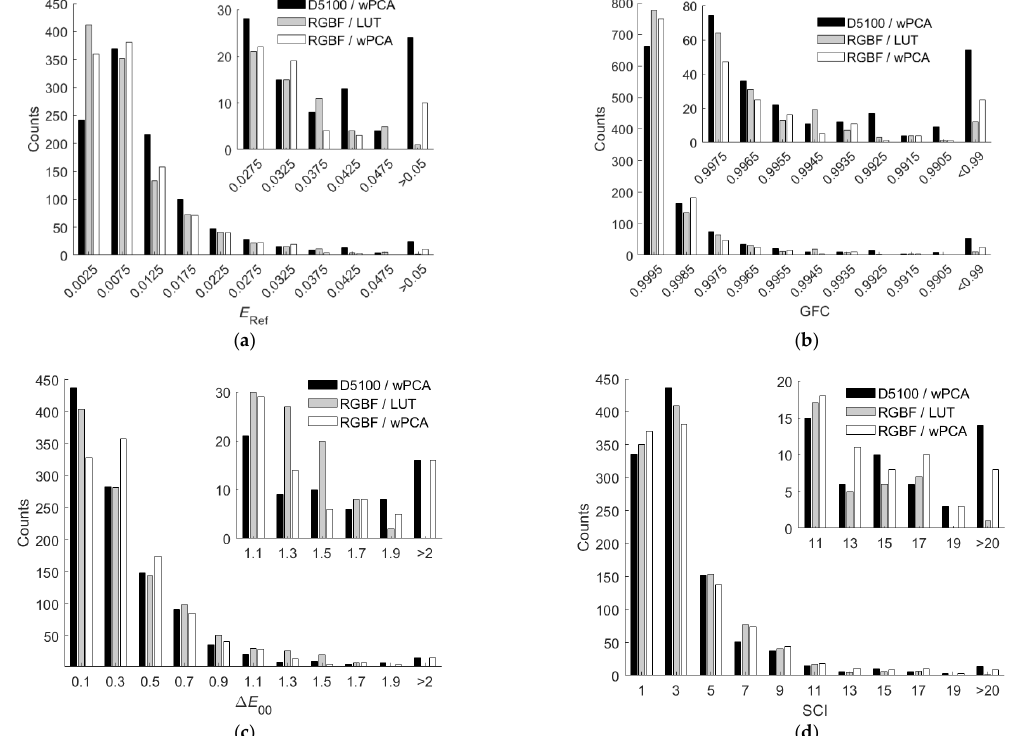
Figure 8. ( a ) E Ref , ( b ) GFC, ( c ) Δ E 00 and ( d ) SCI histograms for the 1066 test samples. The correspond- ing camera and spectrum reconstruction method are shown in figures. The insets in ( a – d ) show enlarged